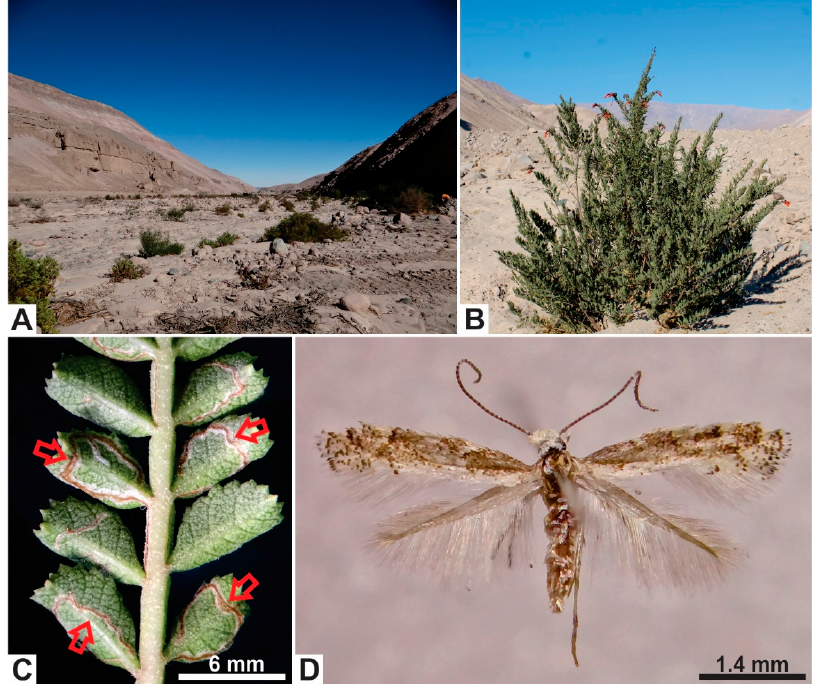
Figure 1. Habitat and host plant of Angelabella tecomae (Gracillariidae). ( A ) Habitat of A. tecomae in the type locality, the Azapa Valley, northern Chile. ( B ) The main host plant in the type locality, Tecoma fulva fulva (Bignoniaceae). ( C ) Detail of a leaf of T. f. fulva showing leaflets and winged rachis mined by larvae of A. tecomae . ( D ) Female adult of A. tecomae in dorsal